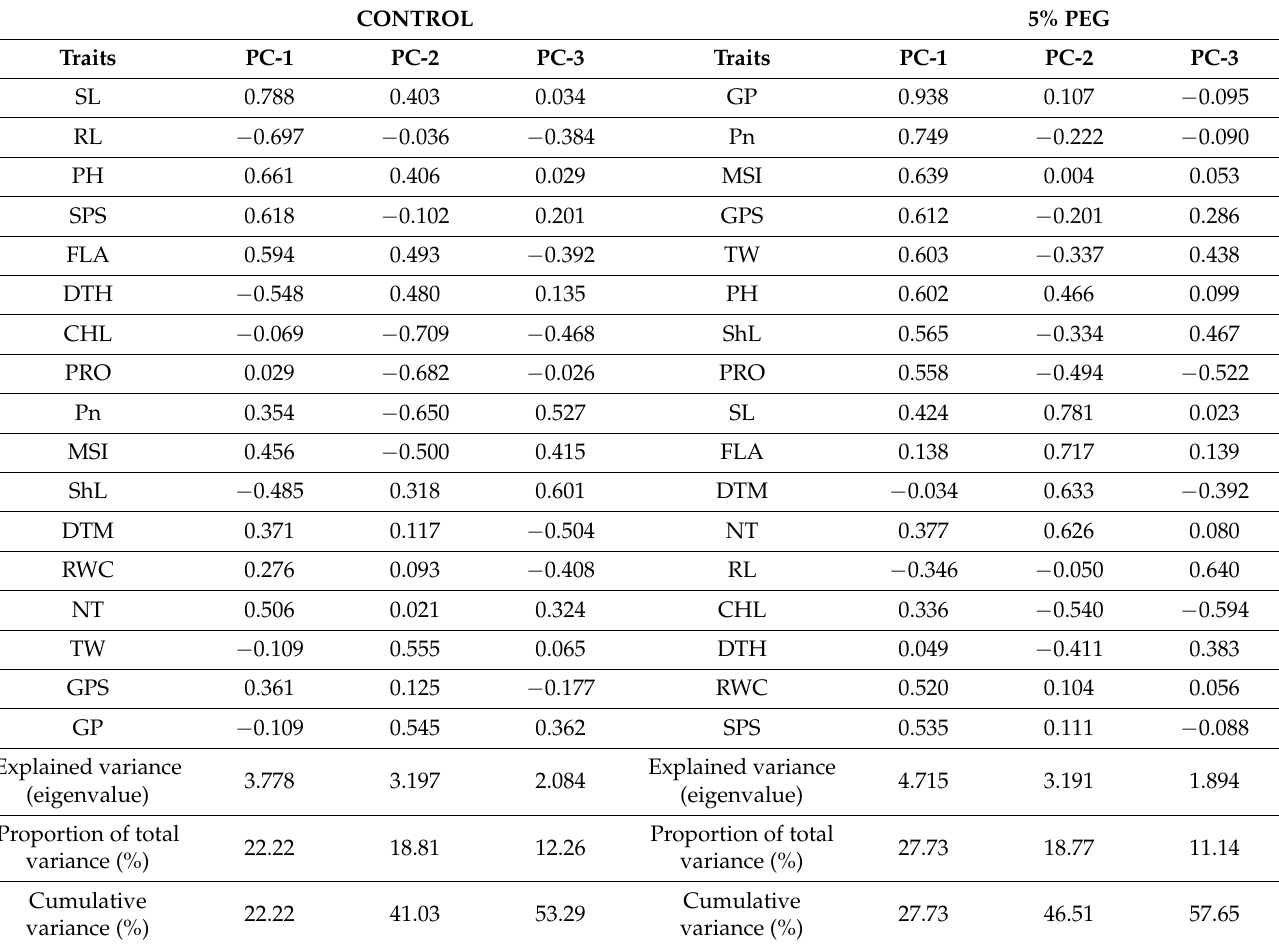
Table 7. Rotated component matrix of morphological, physiochemical and biochemical traits of 15 wheat genotypes under control and 5% PEG treatment conditions. Abbreviations: see Table